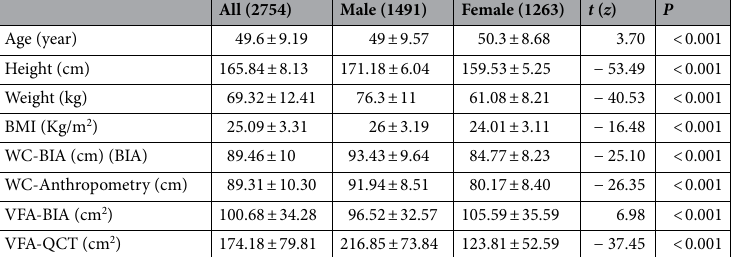
Table 1. The baseline characteristics of the study population.